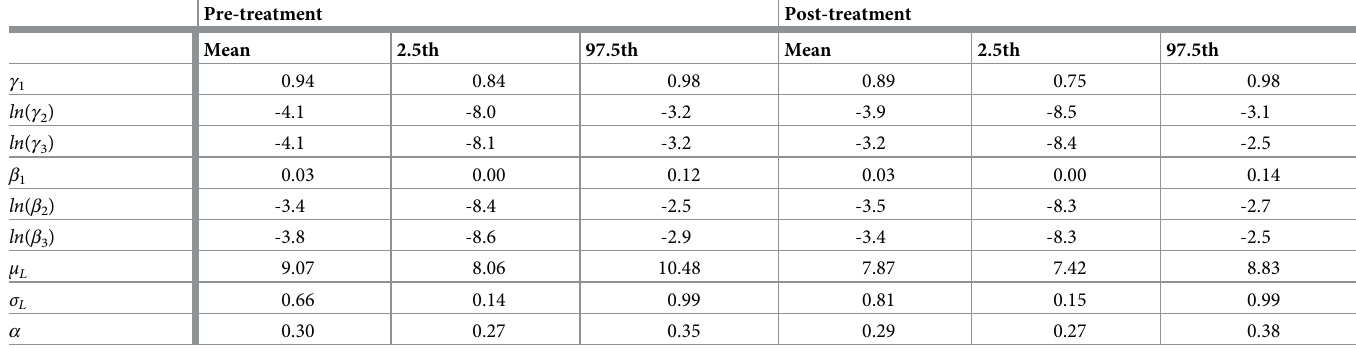
Table 1. Mean, 2.5th and 97.5th quantiles of the posterior distribution of model parameters (full-model) in the pre-treatment and post-treatment phase. Note that γ 2 , γ 3 , β 2 , β 3 are presented on a log scale as values are